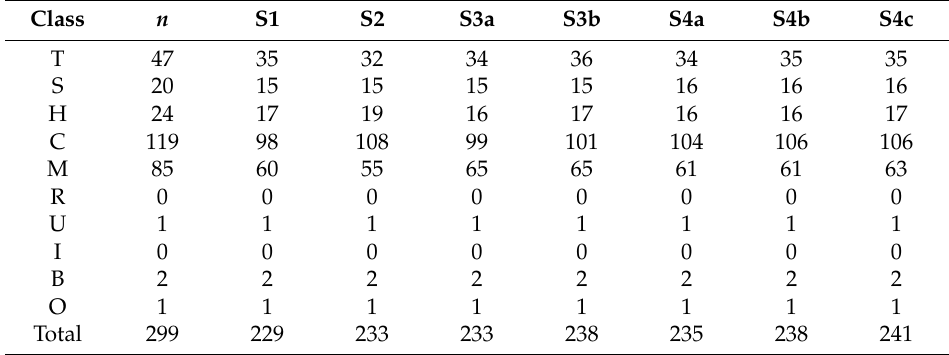
Table 2. Summary of the correct allocations observed in each scenario (S1–S4c) reported for each class and the class size ( n ) in the reference data set; complete confusion matrices for two key classifications are given in Tables 3 and 4.